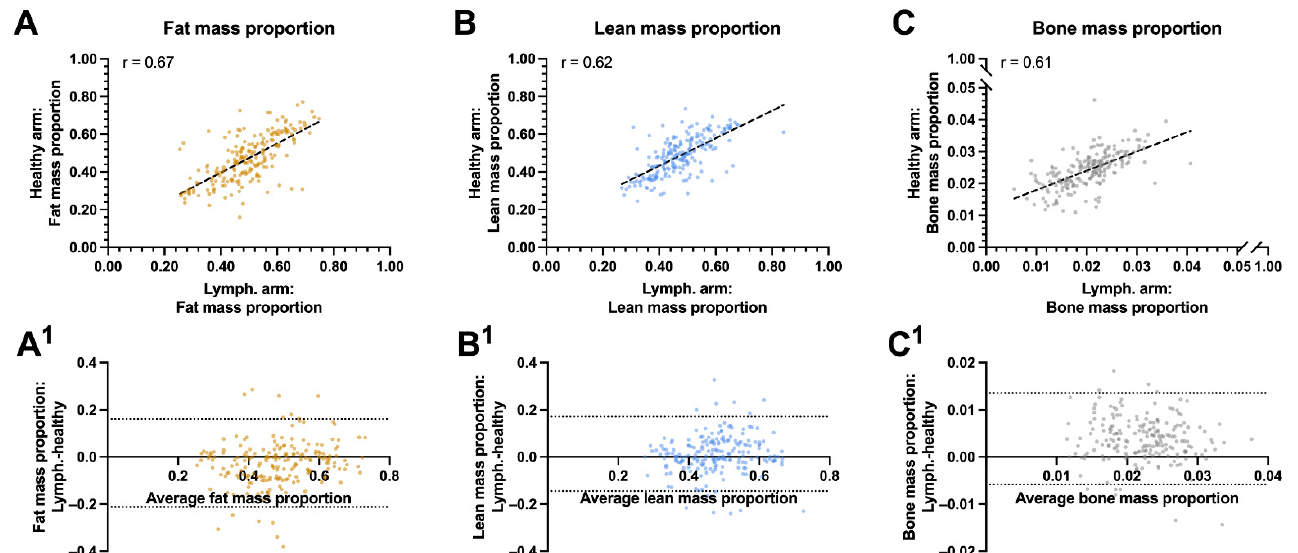
Figure 3. Correlation and agreement between biocomposition proportions between the lymphedema and healthy arms: This figure shows the correlation and agreement between the lymphedema and healthy arms proportion of fat, lean and bone mass. ( A ) Fat mass to whole arm ratio between the lymphedema and healthy arm. ( A 1 ) Agreements between the fat mass proportion of the lymphedema and healthy arm. ( B ) Lean mass to whole arm proportion between the lymphedema and healthy arm. ( B 1 ) Agreements between the lean mass proportion of the lymphedema and healthy arm. ( C ) bone mass to whole arm proportion between the lymphedema and healthy arm. ( C 1 ) Agreements between the bone mass proportion of the lymphedema and healthy arm. The whole arm proportion of lean, fat and bone mass correlated moderately between the lymphedema and healthy arm and there was a good agreement between the proportion of fat mass, lean mass and bone mass Cancers 2021 , 13 , x FOR PEER REVIEW 11 of 16 in the lymphedema and healthy arm. The striped lines shows the line of best fit in panel A, B and C. The horizontal dotted lines denote the 95% confidence intervals for the limits of agreements in panel A 1 , B 1 , and C 1 . R = pearson correlation.